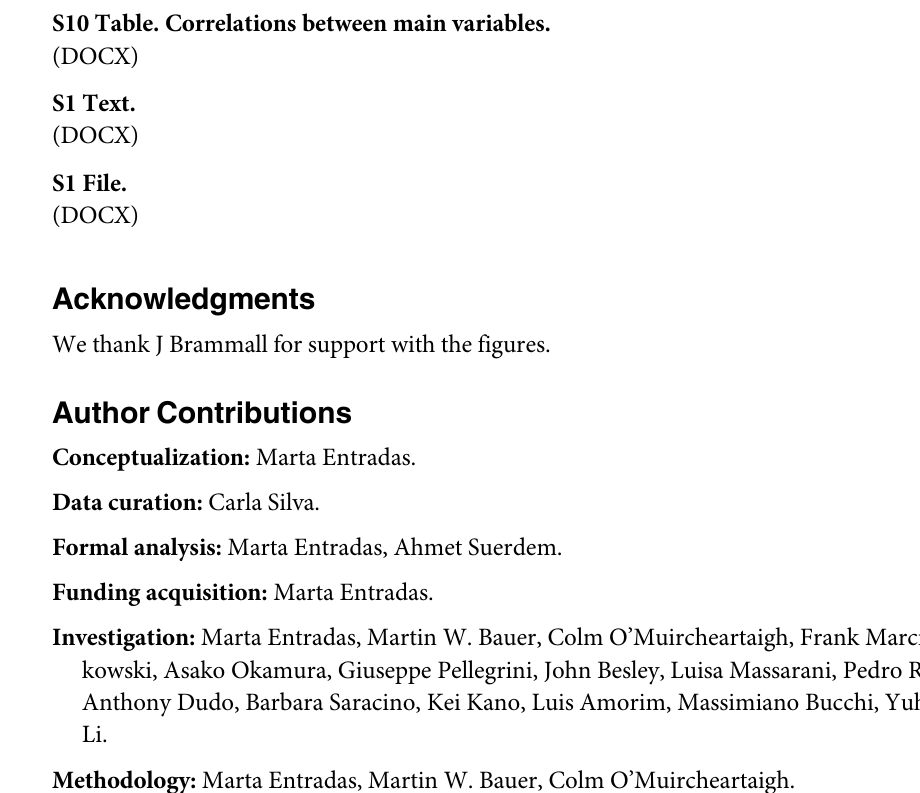
S10 Table. Correlations between main